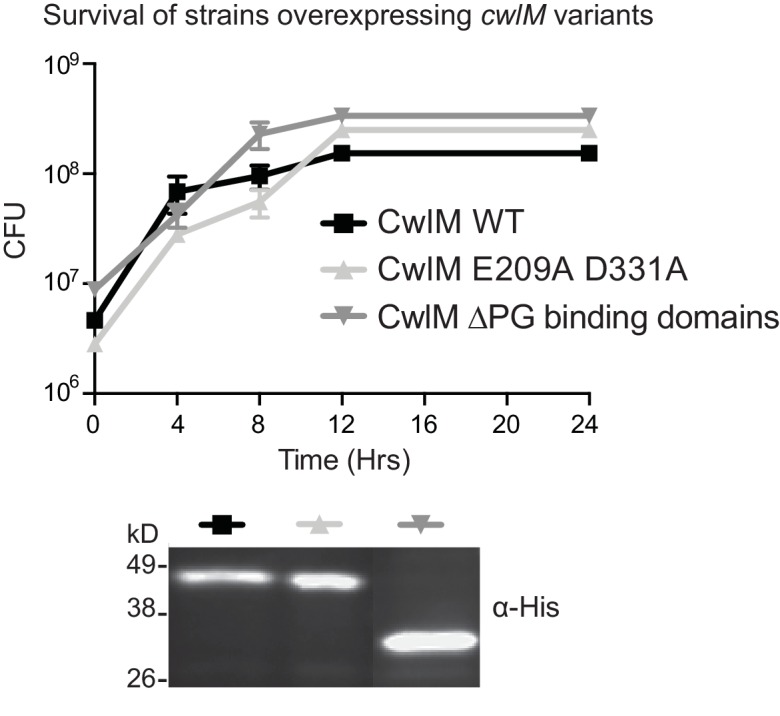
Overexpression of CwlM.Colony forming units of Msmeg strains overexpressing wild-type (CB193), the amidase ablated allele of cwlM (CB194), and the amidase domain alone (CwlM ∆PG binding domains, CB202), and an α-His western blot showing that these proteins are expressed. Proteins were expressed from Atc-inducible promoters on episomal vectors.